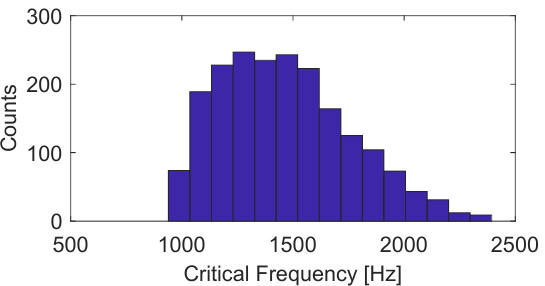
Figure 4. Histogram of the critical frequencies from the STL designs in the set of interest from Table 1.